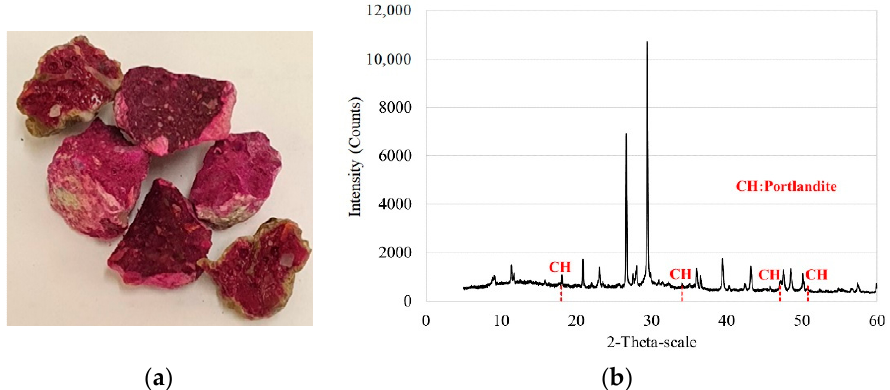
Figure 2. Recycled aggregates were uncarbonated: ( a ) the phenolphthalein (pink colour) showed the presence of Ca(OH) 2 ; ( b ) DRX analysis shows Ca(OH) 2 .